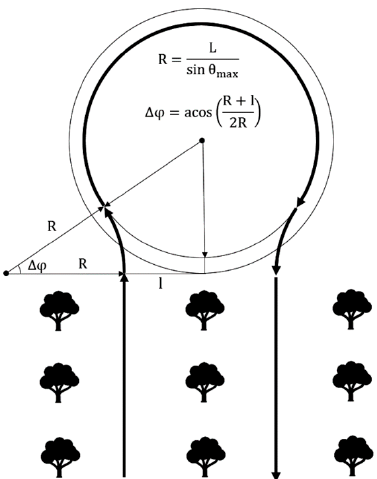
Figure 10. Calculation of controls on a complex trajectory.